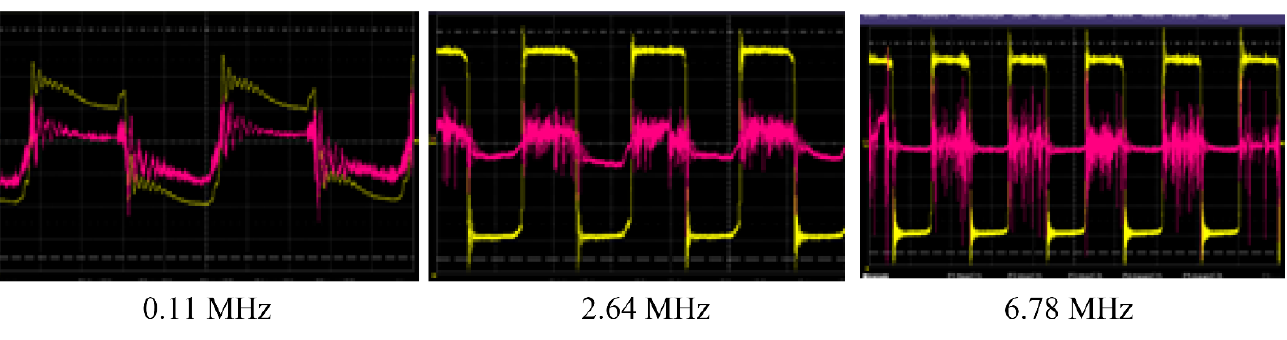
Figure 3. Graphs of current (red curve) and voltage (yellow curve) in the active electrode (AE) – electrolyte-neutral electrode (NE) circuit.